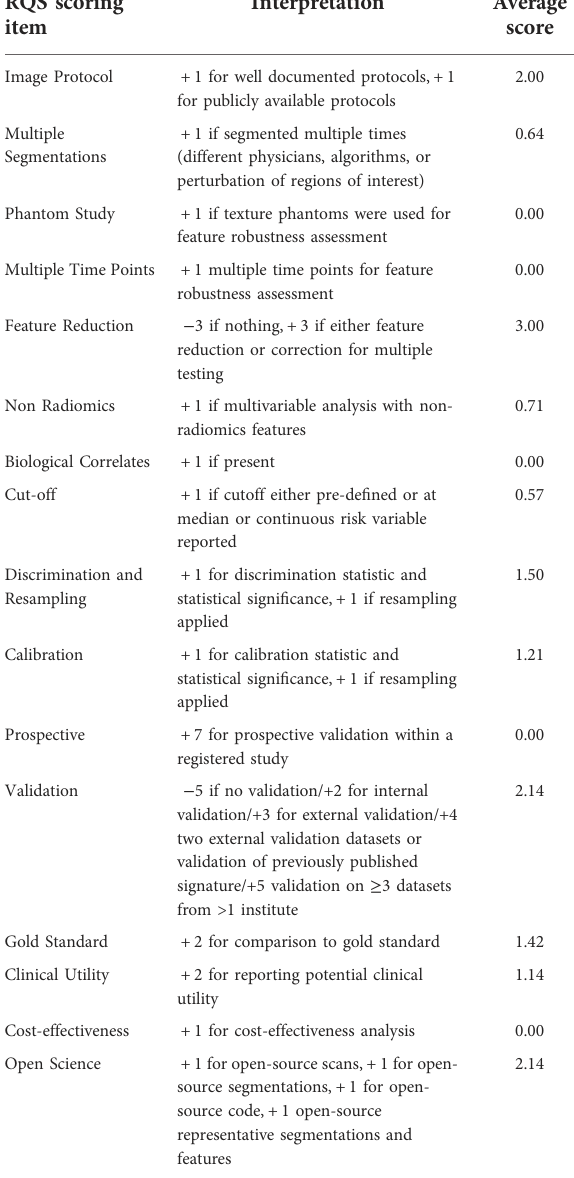
TABLE 2 RQS elements and the mean rating of our eligible